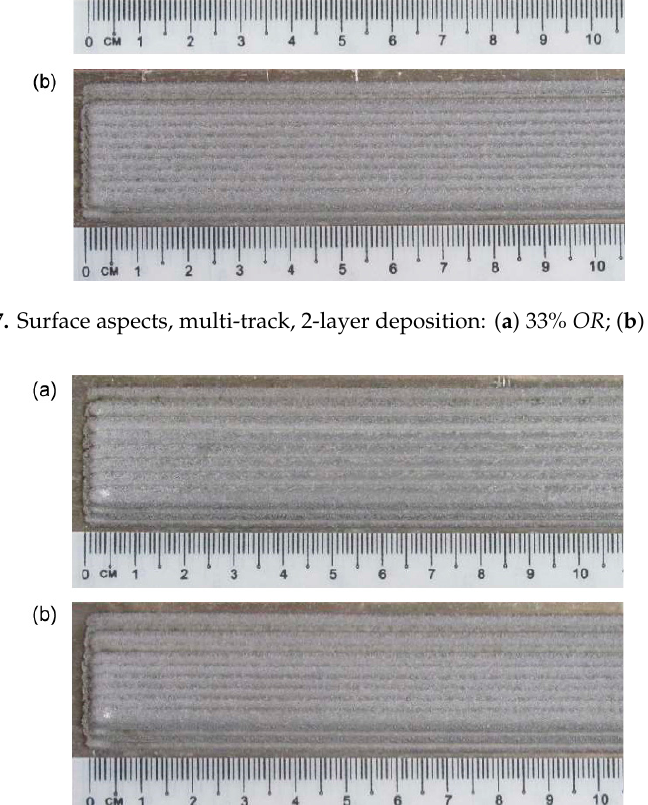
Figure 8. Surface aspects, multi-track, 3-layer deposition: ( a ) 33% OR ; ( b ) 50% OR .